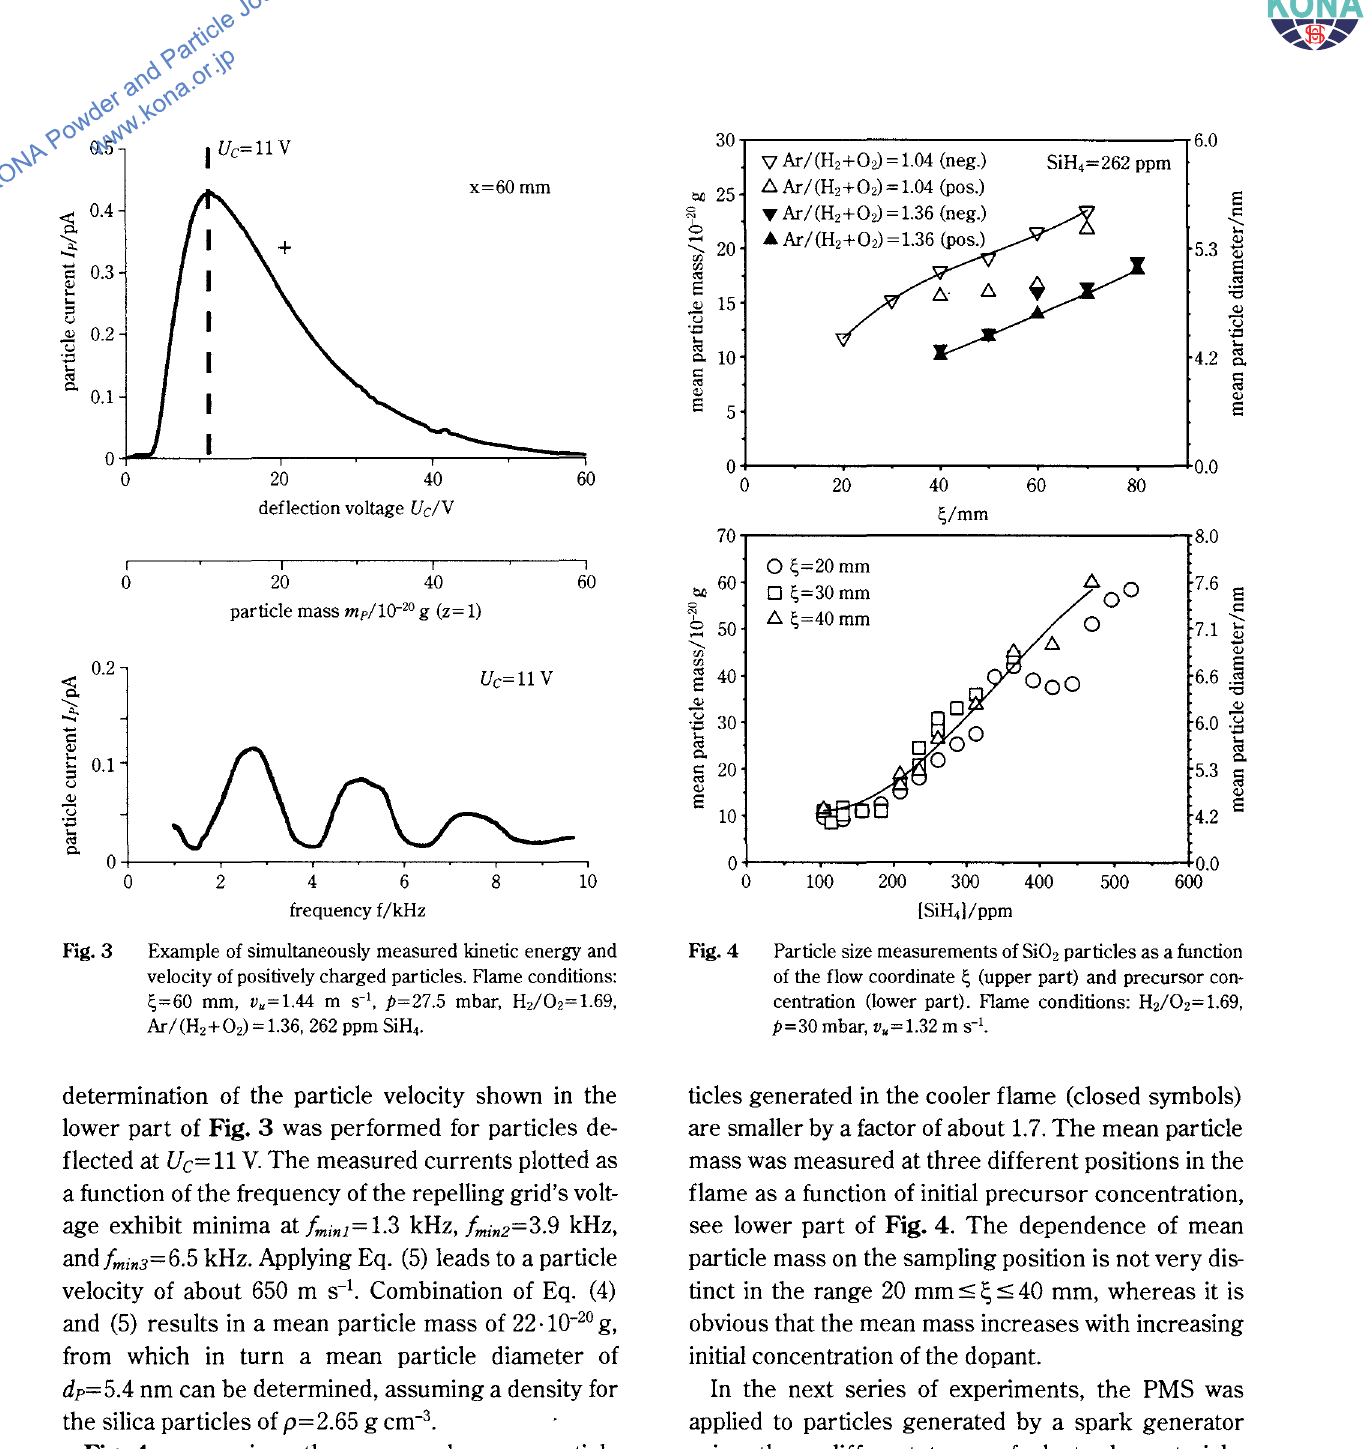
Fig. 4 Particle size measurements of Si0 2 particles as a function of the flow coordinate ~ (upper part) and precursor con centration (lower part). Flame conditions: H 2 /0 2 = 1.69, P=30 mbar, v.=L32 m s- 1• tides generated in the cooler flame (closed symbols) are smaller by a factor of about 1.7. The mean particle mass was measured at three different positions in the flame as a function of initial precursor concentration, see lower part of Fig. 4. The dependence of mean particle mass on the sampling position is not very dis tinct in the range 20 mm ::5 ~ ::5 40 mm, whereas it is obvious that the mean mass increases with increasing initial concentration of the dopant. In the next series of experiments, the PMS was applied to particles generated by a spark generator using three different types of electrode materials. Conventional spark plug material was operated at atmospheric pressure, a silver electrode was used at 400 mbar, and for glassy carbon (Sigradur-G), the pressure was held between 20 and 30 mbar. Fig. 5 shows results of the measured probability density of the particle diameter obtained from the three materi als at a spark frequency ot'/=1000 Hz. All particles show a very narrow size distribution with mean parti cle sizes between 2 and 4 nm. Fig. 6 shows the depen dence of particle size on both the spark frequency and the ignition voltage. The mean particle